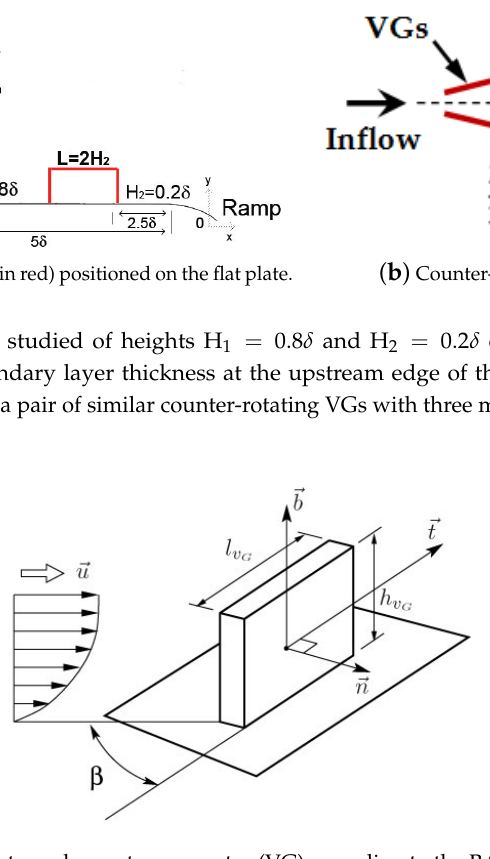
Figure 3. Unit vectors on a rectangular vortex generator (VG) according to the BAY Source Term